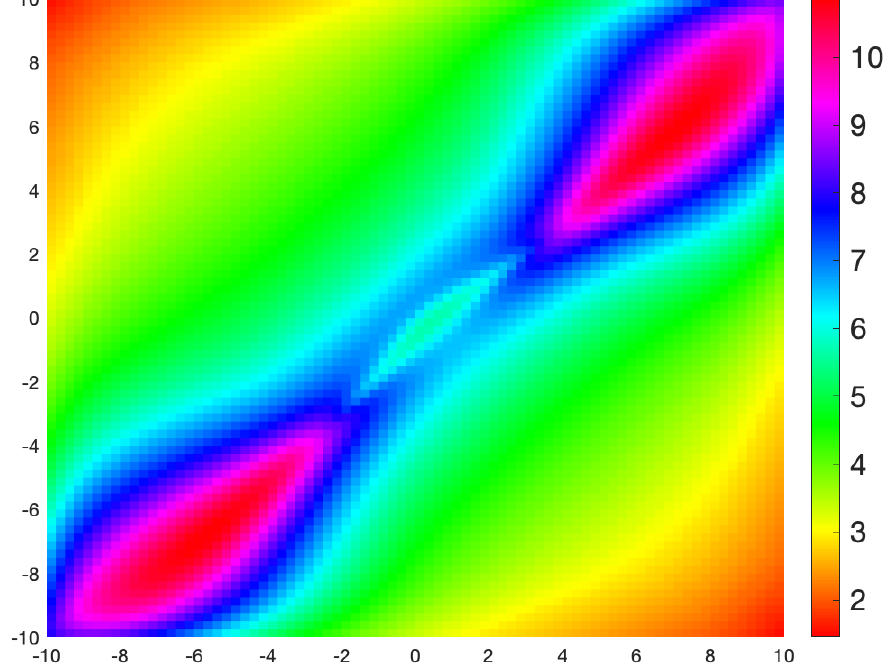
Figure 9. Geodesic speed sensor moving along a geodesic in direction (1, − 1) at each point in Ω = [ − 10,10 ] × [ − 10,10 ] . The other sensor is stationary at ( − 7, − 6 ) , and an uninformative prior is used for the target. The actual positions of the sensor are raised above Ω by a distance